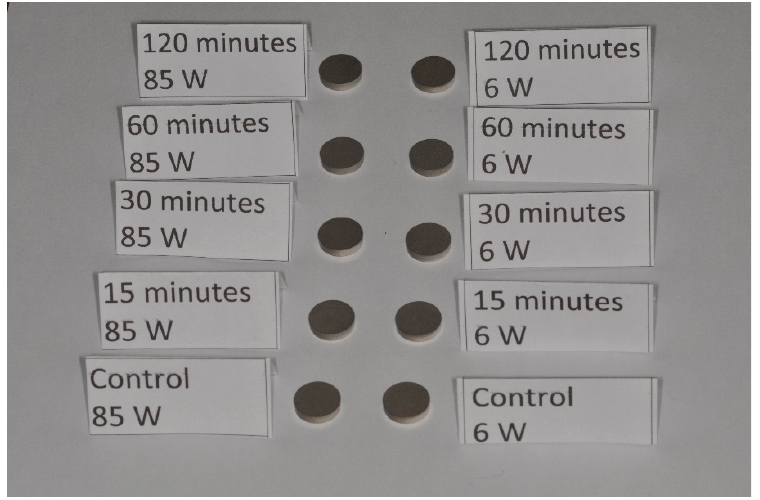
Figure 3. Distribution of discs into groups irradiated with 6 or 85 W according to irradiation time. Statistical analysis was performed using IBM SPSS ver. 23.0 (IBM Co., Armonk, NY, USA). A normality assumption for the data was tested using the Shapiro–Wilk